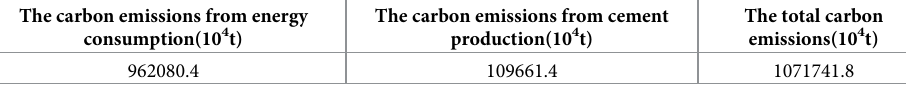
Table 4. The carbon emissions from the energy consumption and the cement production. The carbon emissions from energy The carbon emissions from cement consumption(10 4 t) production(10 4